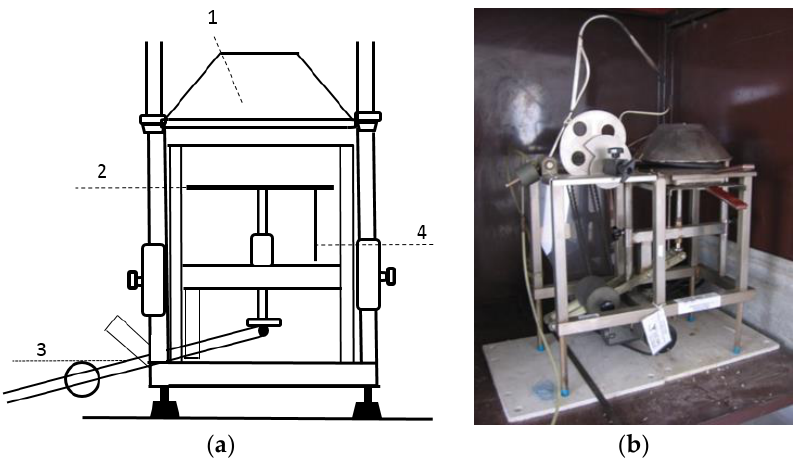
Figure 3. ( a ) Scheme of the equipment for determination of flammability of materials at a heat flux of radiant heat of 10 – 50 kW.m − 2 according to [24]; ( b ) a photo of the real test equipment [31]. Legend: 1, heating cone; 2, board for sample; 3, movable arm; 4, connection point for recording experimental data.